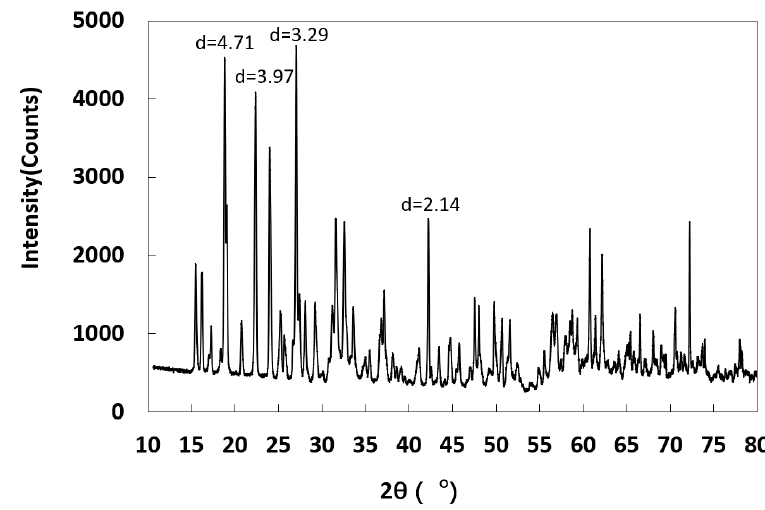
Figure 7. XRD curve of salt crystal zone in sample C2.